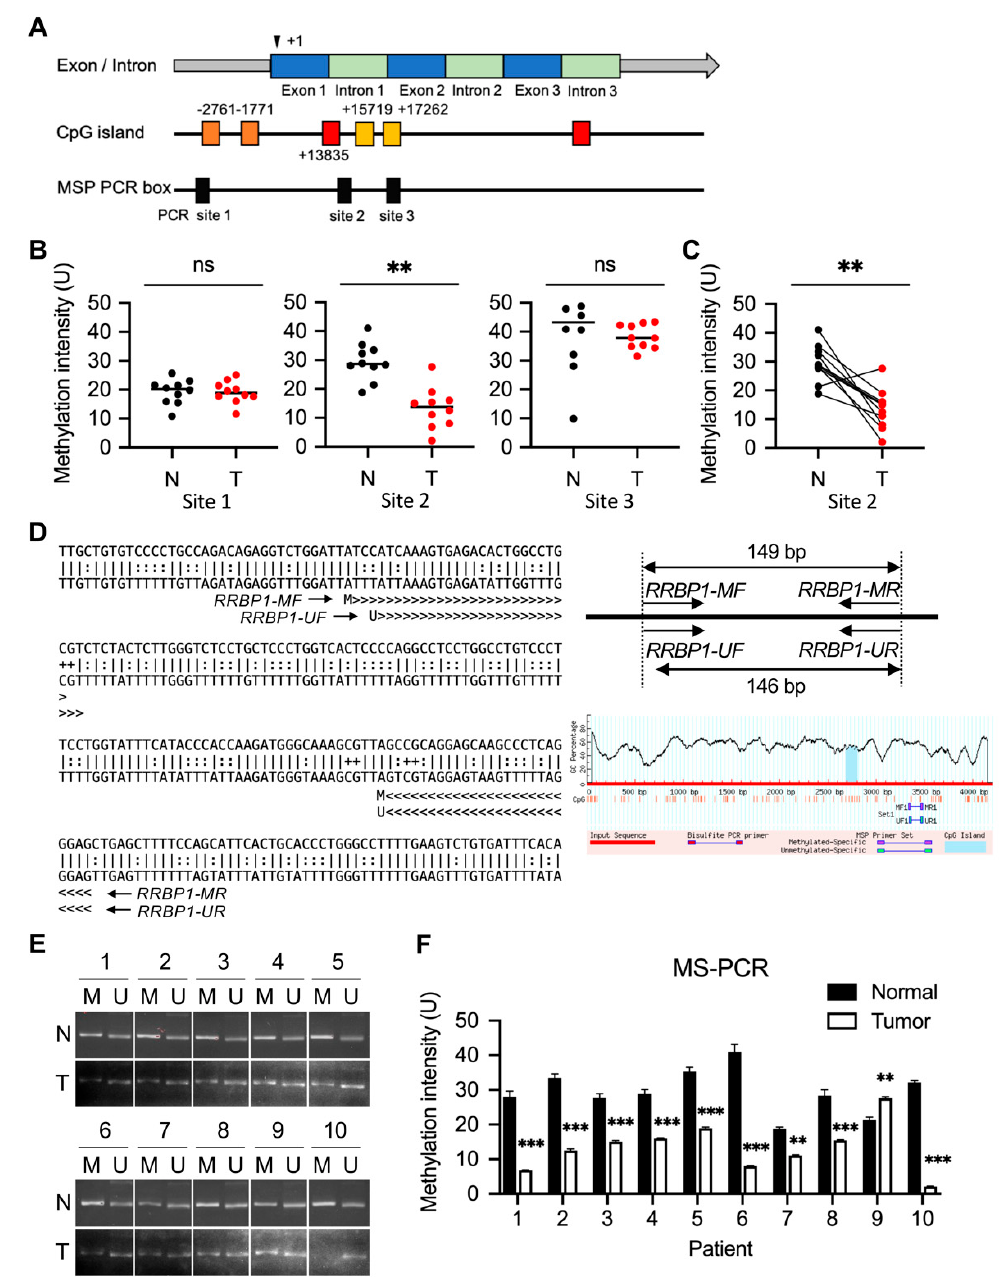
Figure 3. Low methylation of RRBP1 in tumors of UTUC. ( A ) RRBP1 is encoded on chromosome 20. Predicted CpG islands of RRBP1 in the region of exon 1 to intron 3 (chromosome GRCh38:17,613,678-17,682,283) are represented. Illustration represents the design of the methylation-specific PCR assay and the position of the primer sets in CpG islands. ( B ) Low methylation in CpG island of RRBP1 in N/T pairs of UTUC tumors. (** p < 0.01.) Student t -test with two-tailed p -value. ( C ) Methylation intensity of RRBP1 in N/T pairs of UTUC tumors. (** p < 0.01.) Paired t -test with two-tailed p -value. ( D ) Sequence of predicted primer sets for site 2 CpG island. ( E ) Differential level of methylation in site 2 CpG islands of RRBP1 from N/T pairs of UTUC. ( F ) Quantification of methylation in site 2 CpG islands of RRBP1 from N/T pairs of UTUC. (** p < 0.01; *** p < 0.001.) Statistical analysis was performed by using two-way ANOVA with Tukey’s multiple comparison test.